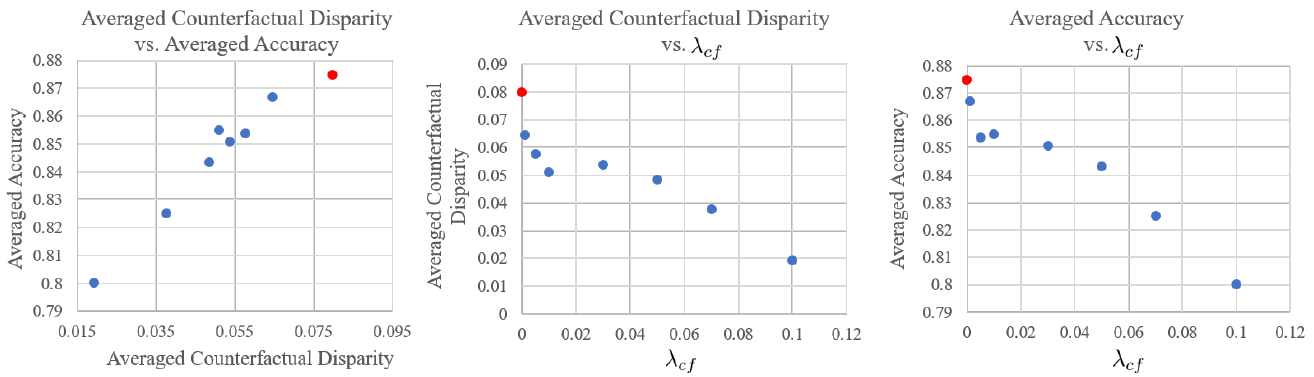
Figure 5. Trade-off analysis of the proposed learning method for counterfactual fairness. Here, the averaged counterfactual disparity is defined as the aggregation over all E ( CDP i ) and the averaged prediction accuracy in the same manner. Each blue dot is obtained with a different value of λ cf , and the red dot represents baseline